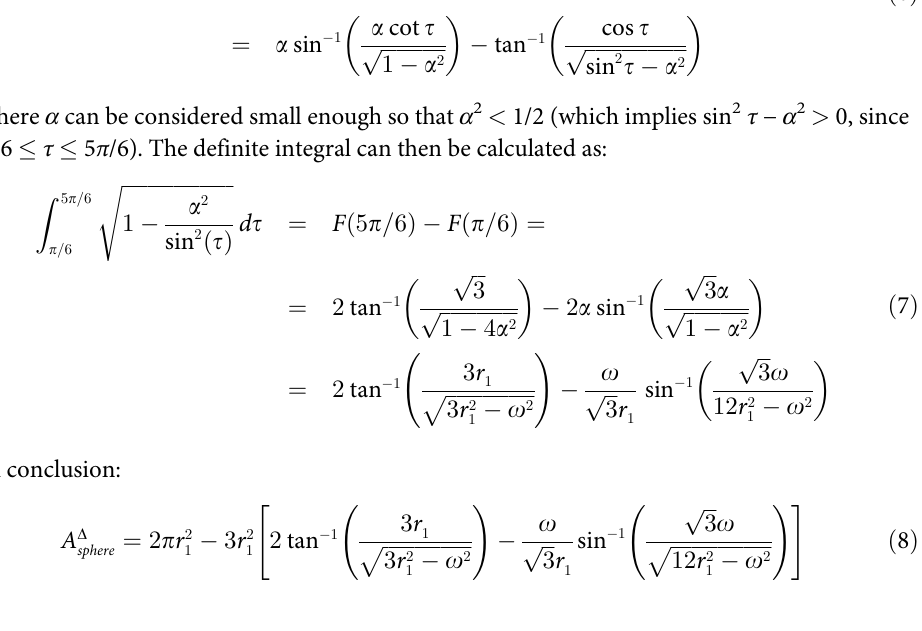
a cot t ffiffiffiffiffiffiffiffiffiffiffiffiffi